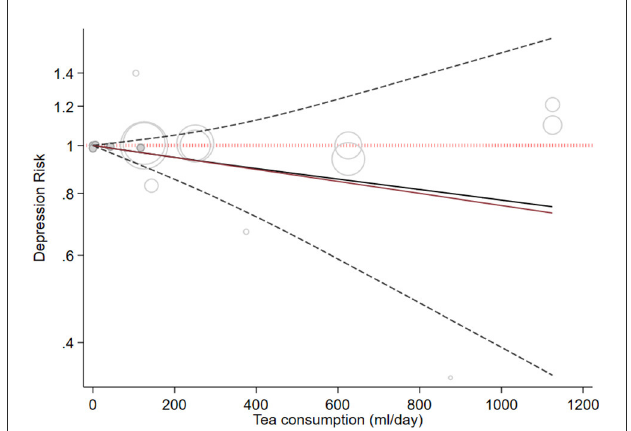
FIGURE4 Dose-response association between tea intake and depressive symptoms. The solid line represents a non-linear dose response, and the dotted lines represent a 95% confidence interval. Circles represent hazard ratio point estimates for coffee intake categories from each study with circle size proportional to the inverse of standard error.